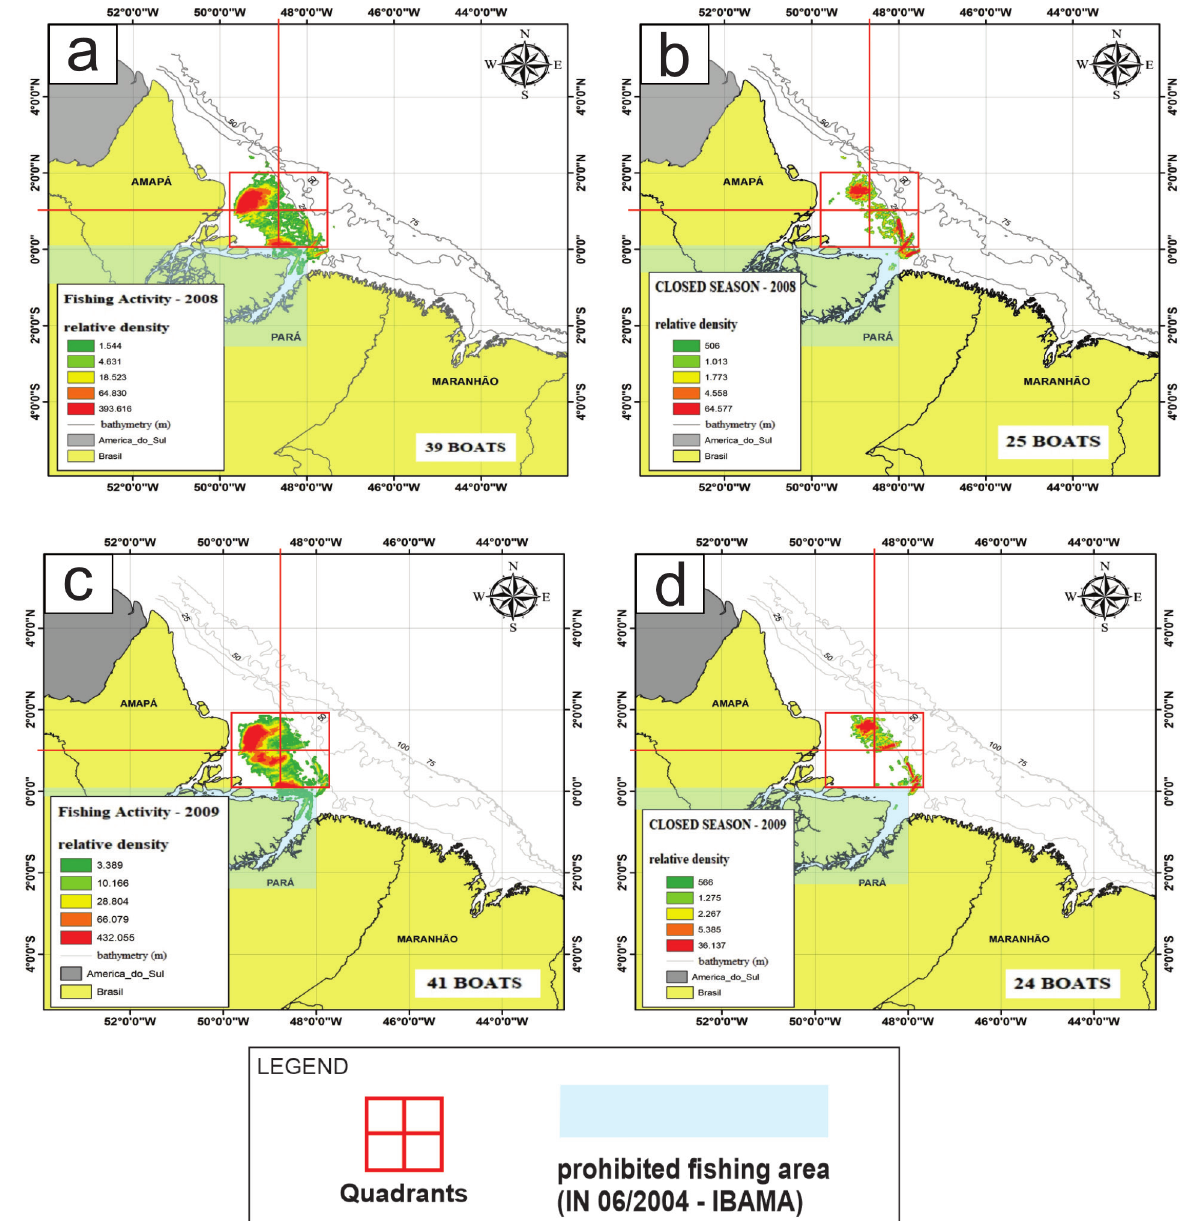
Figure 5. Dynamics of the industrial fleet capturing B. vaillantii and relative density of fishing activity from 2008 (Figures. a and b) to 2009 (Figures. c and d); in the normal period and in the species closure period. The segment outlined in red shows the total area within which the piramutaba trawling fleet